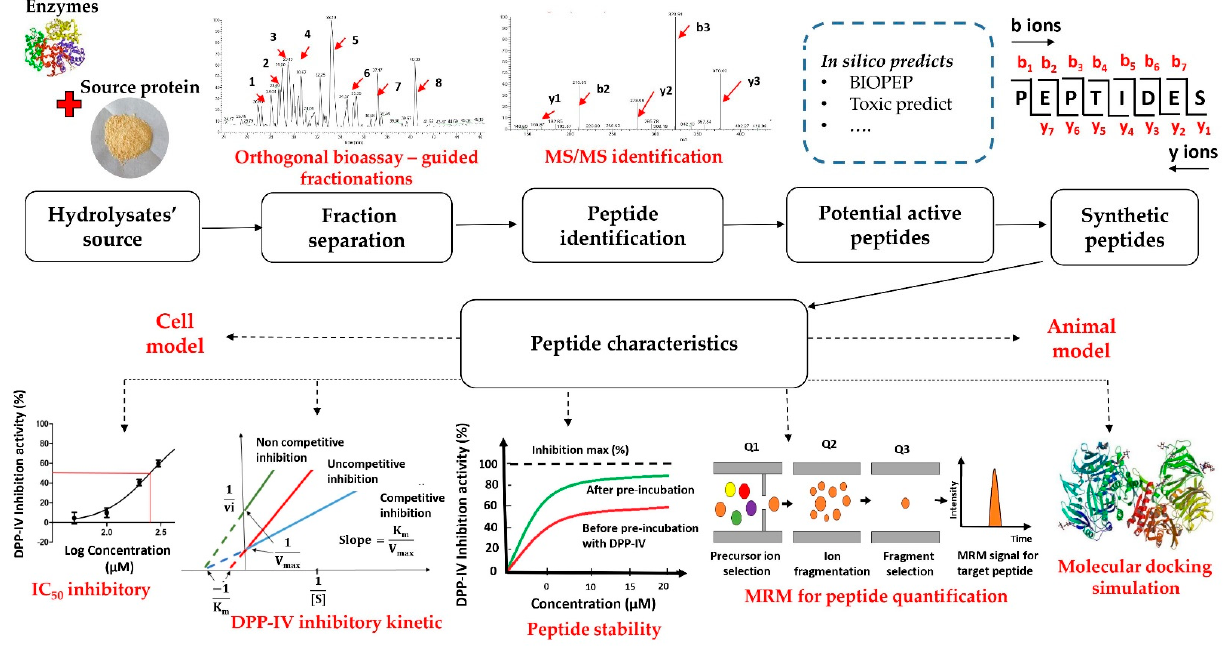
Figure 3. Workflow for discovering DPP-IV inhibitory peptides from food-derived proteins.